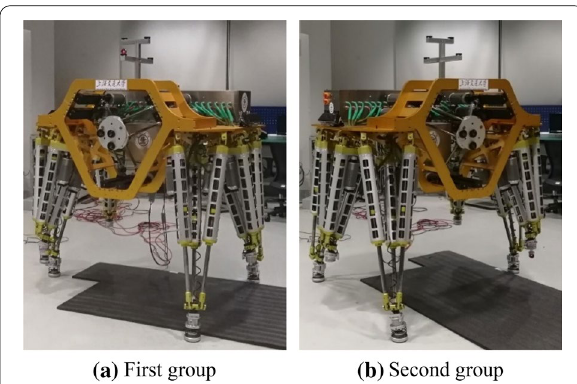
Figure 8 Views from the laser tracker during the calibration of different groups of legs